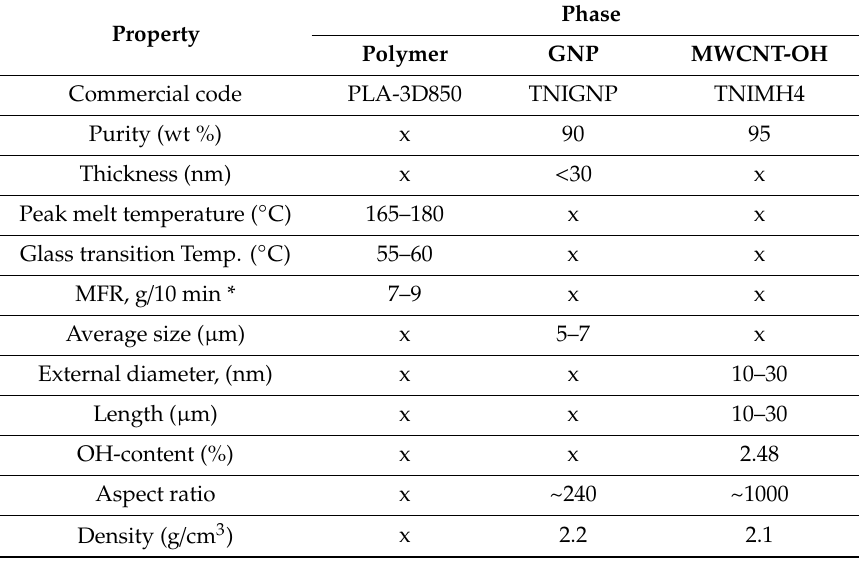
Table 1. Features of the adopted host polymer and carbon-based fillers. Property